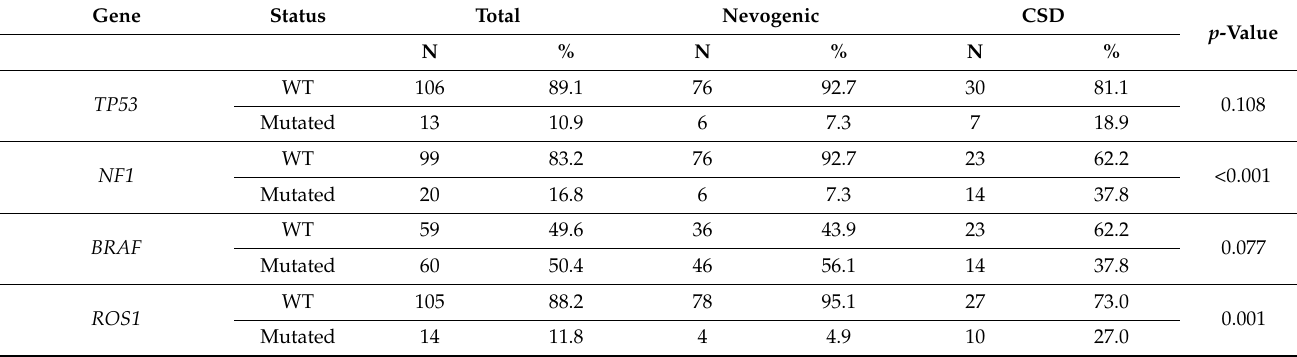
Table 3. Prevalence of mutations according to etiopathogenic group and molecular subgroups.